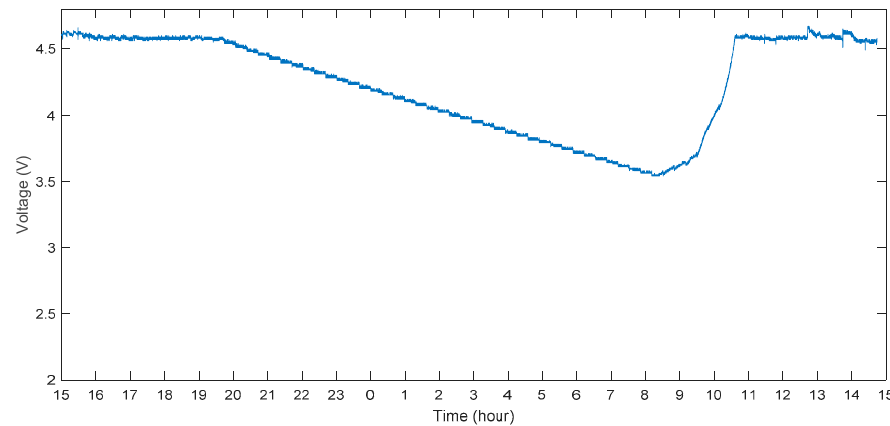
Figure 5. Continuous supercapacitor voltage-monitoring from 15:00 to 15:00 AEDT (Date: 18 October 2016, Clayton Victoria, Australia).